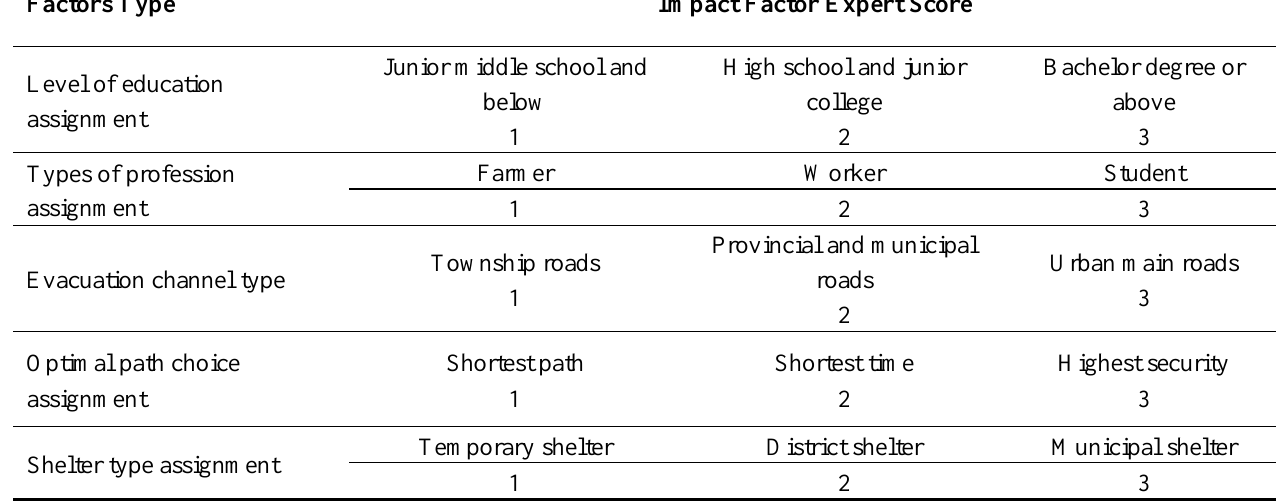
Table 2. Impact factor grading and scoring of evacuation behavior.